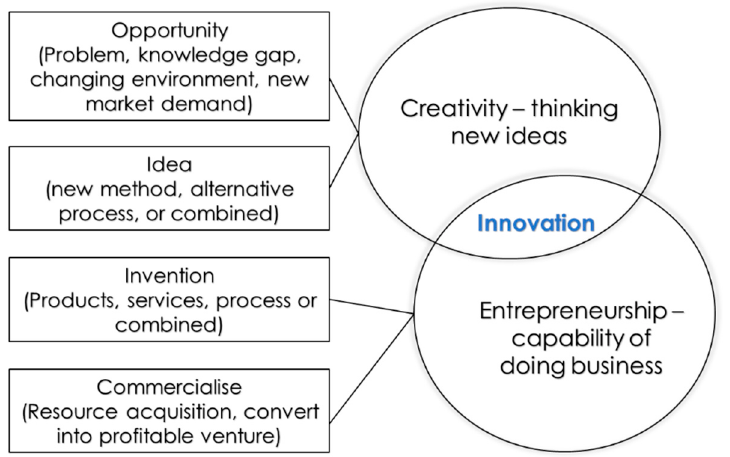
Figure 5. Interrelationships between Creativity, Innovation and Entrepreneurship. Source: Adapted with modification from Pretorius, M., Millard, S. M., & Kruger, M. E. [39].